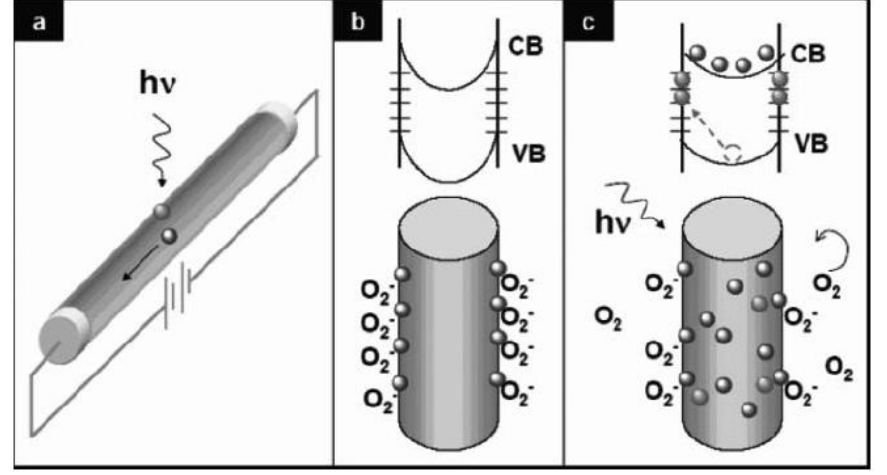
Figure 15. Photocurrent transport mechanism in a nanowire (reprinted from Reference